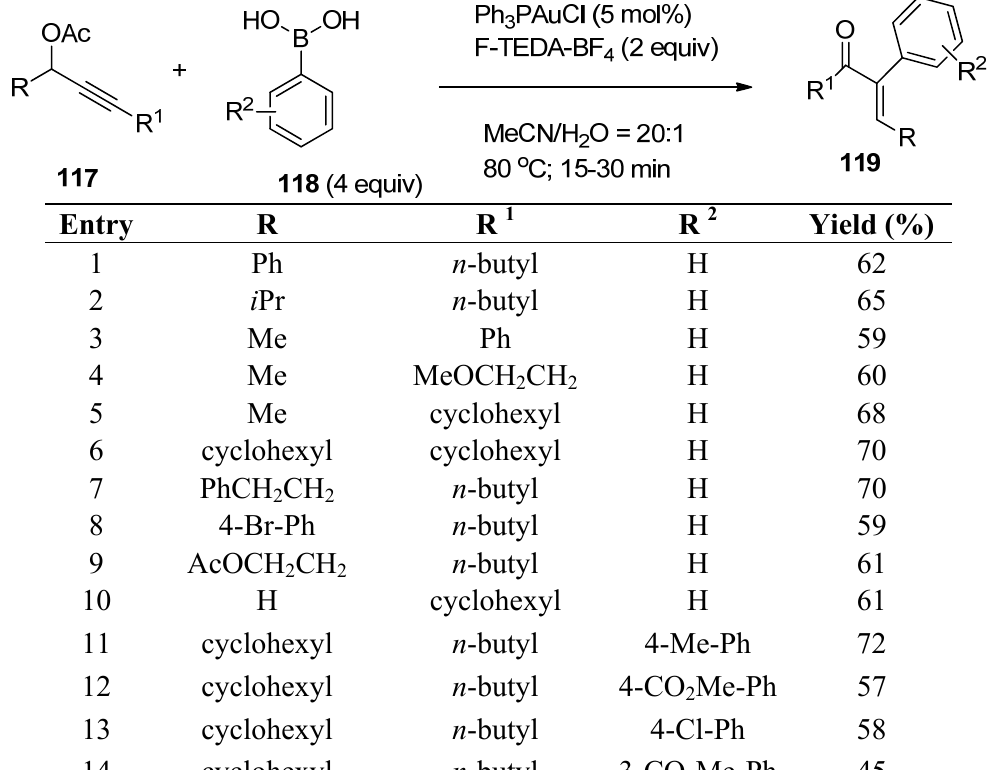
Table 10. Gold-catalyzed oxidative cross-coupling of propargyl acetates with boronic